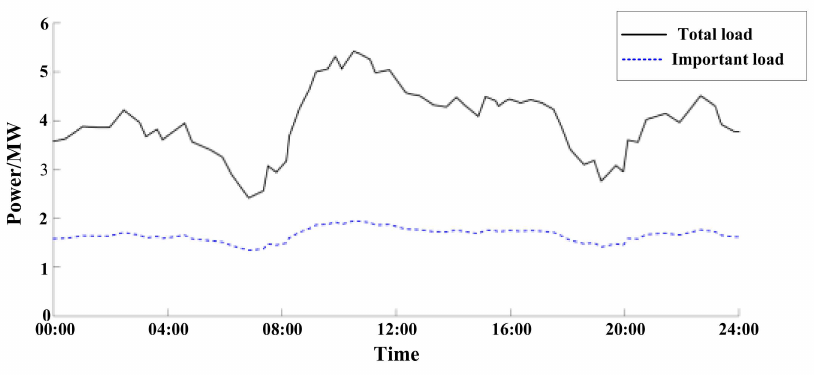
Figure 4. User’s typical daily load curve.